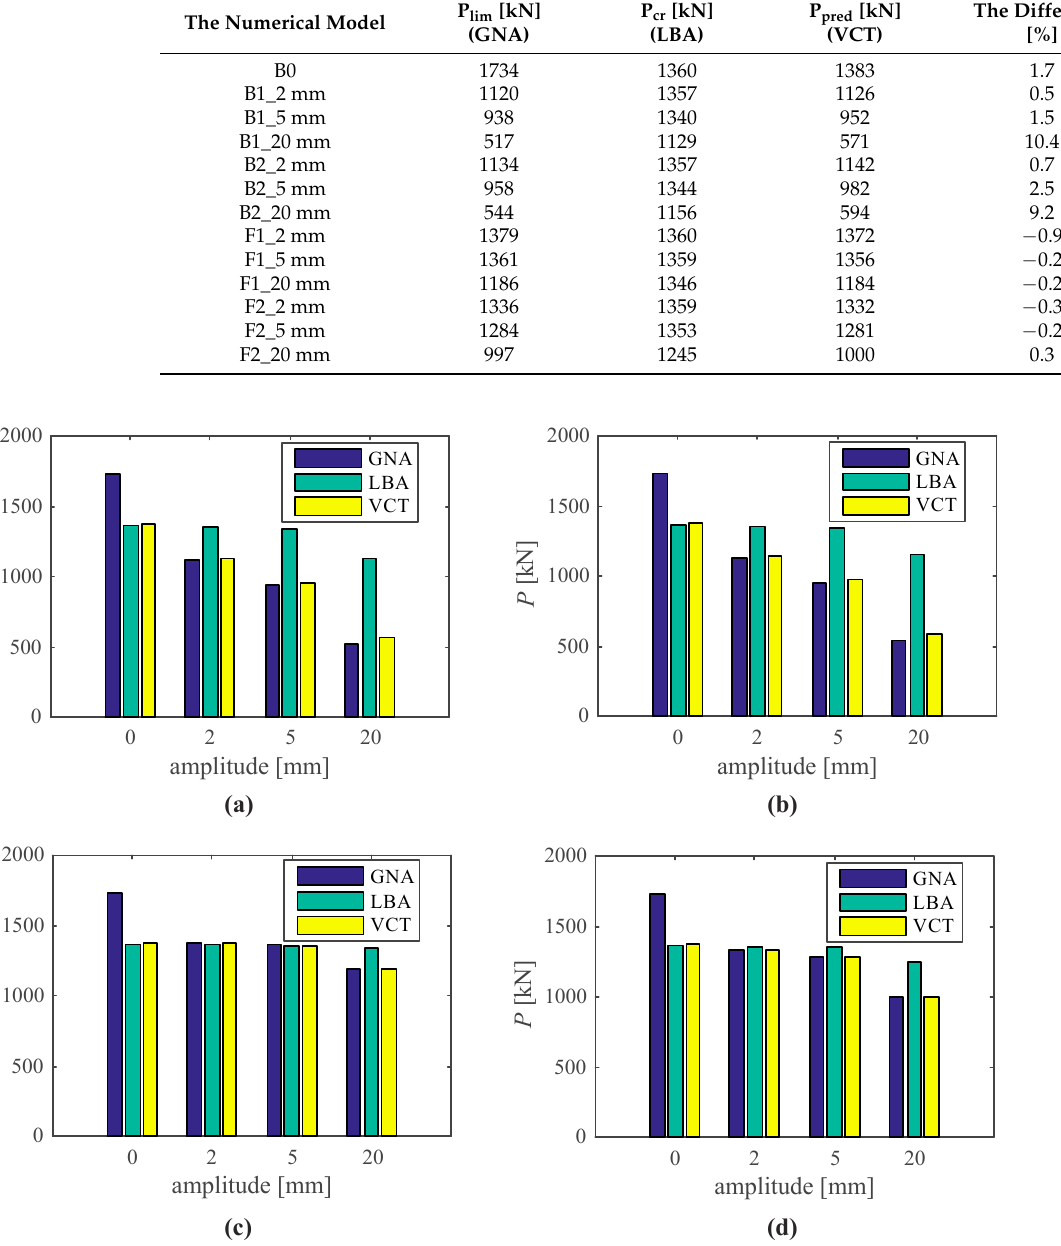
Table 1. Summary of the GNA, LBA and VCT results.